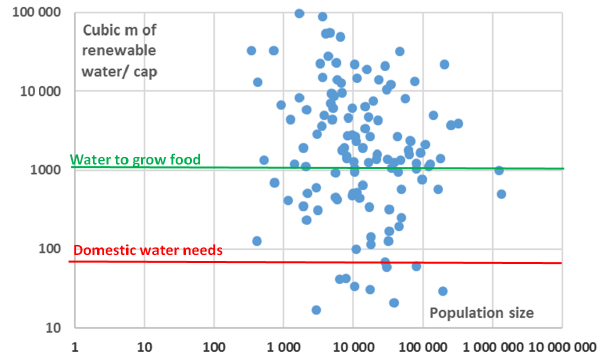
Figure 8. Renewable water per capita against population size by country. The lines the annual water resources needed to grow food (ca. 1200m 3 per capita) and for domestic water supply (a 80m 3 per capita). Many countries do not have enough water to be food-secure, and some lack enough water for domestic use. Figure 9. Water harvesting potential in Africa, based on climatic data. The map shows the ratio of precipitation to potential evapo- transpiration for a 5-month growing season, for the worst 25% of years. At values less than 0.2, water harvesting is only practicable in very favourable situations. Above 1.5, rain-fed farming generally provides an adequate crop without water harvesting.